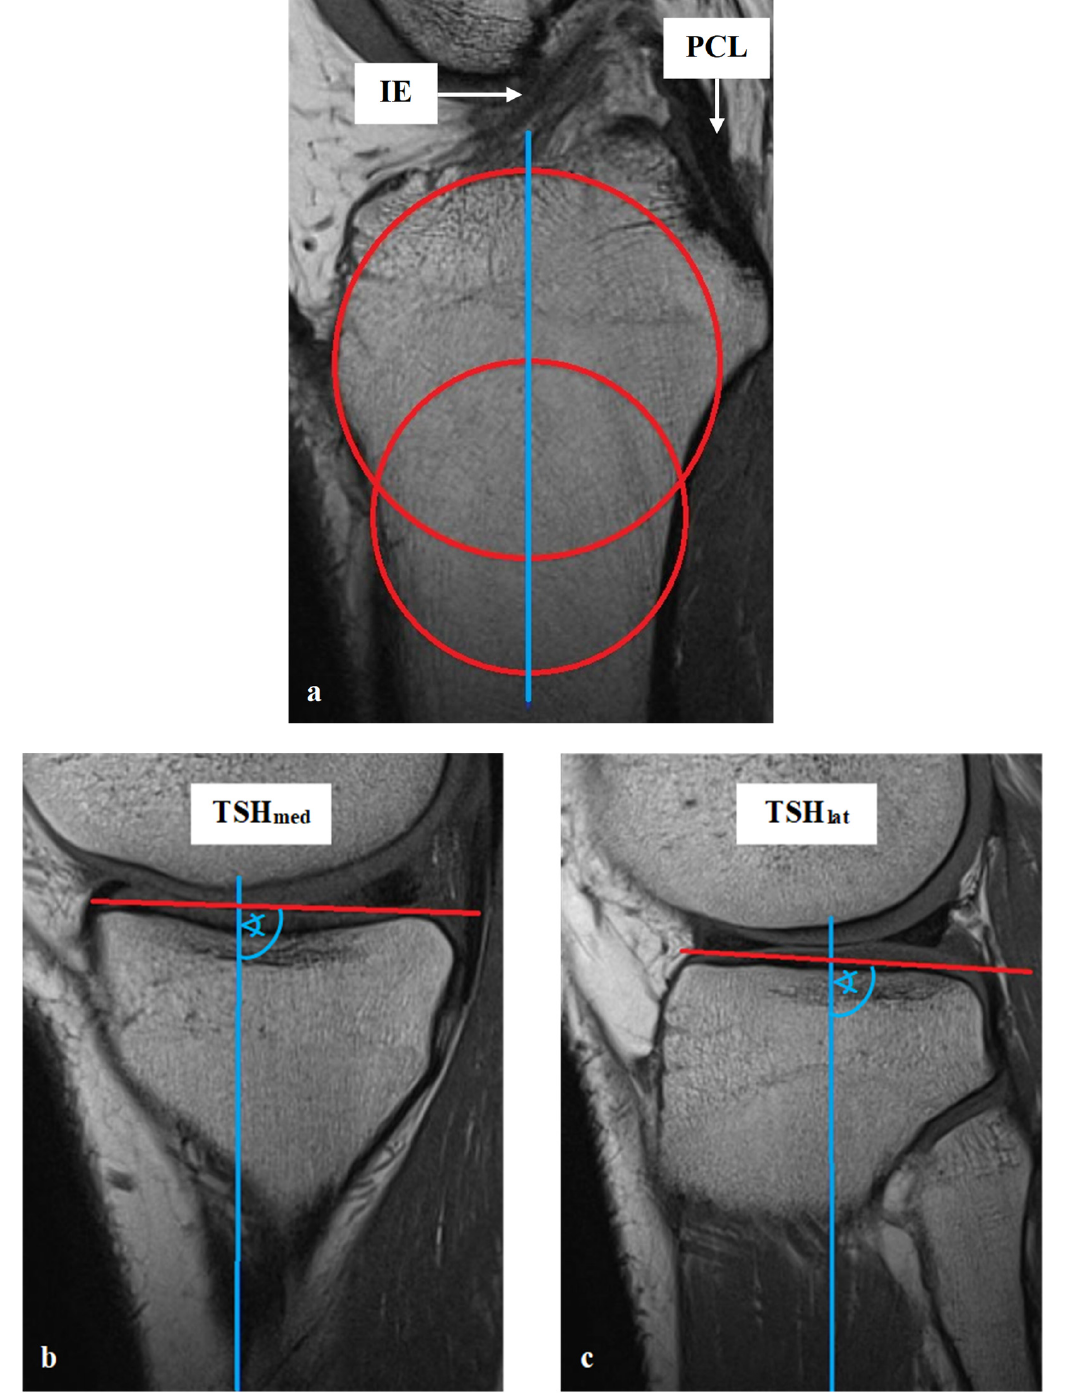
Figure 2. Exemplary depiction of the measurements of the tibial slope according to Hudek et al. [38] for medial (TSH med , ( b )) and lateral (TSH lat , ( c )) knee-joint surface: The measurements of TSH were performed in sagittal view of the knee joint in MRIs. To determine the right position of tibial-shaft axis for each TSH med and TSH lat , a reference line was set in the best available image. To detect the tibial-shaft axis as accurate as possible, two virtual circle stencils were used ( a ). The reference structures were the posterior cruciate ligament (PCL) and the intercondyloid eminence (IE). Based on this reference line, the inclination angle of the tibial plateau was determined in the medial (TSH med , ( b )) and lateral (TSH lat , ( c )) joint sections.